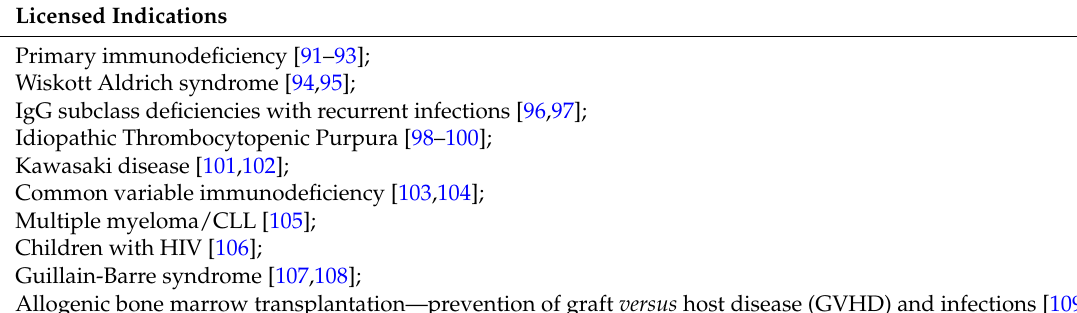
Table 2. List of IVIg